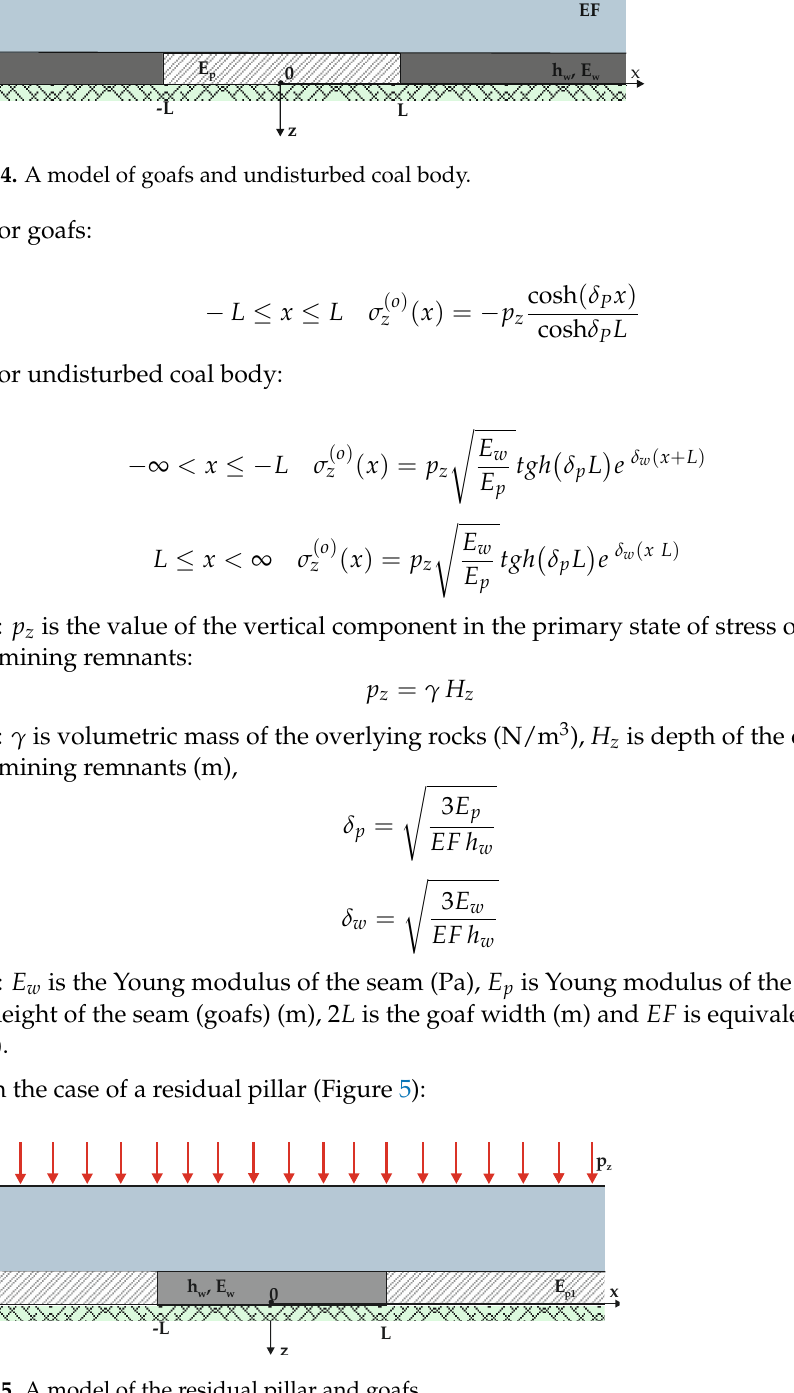
Figure 5. A model of the residual pillar and goafs.